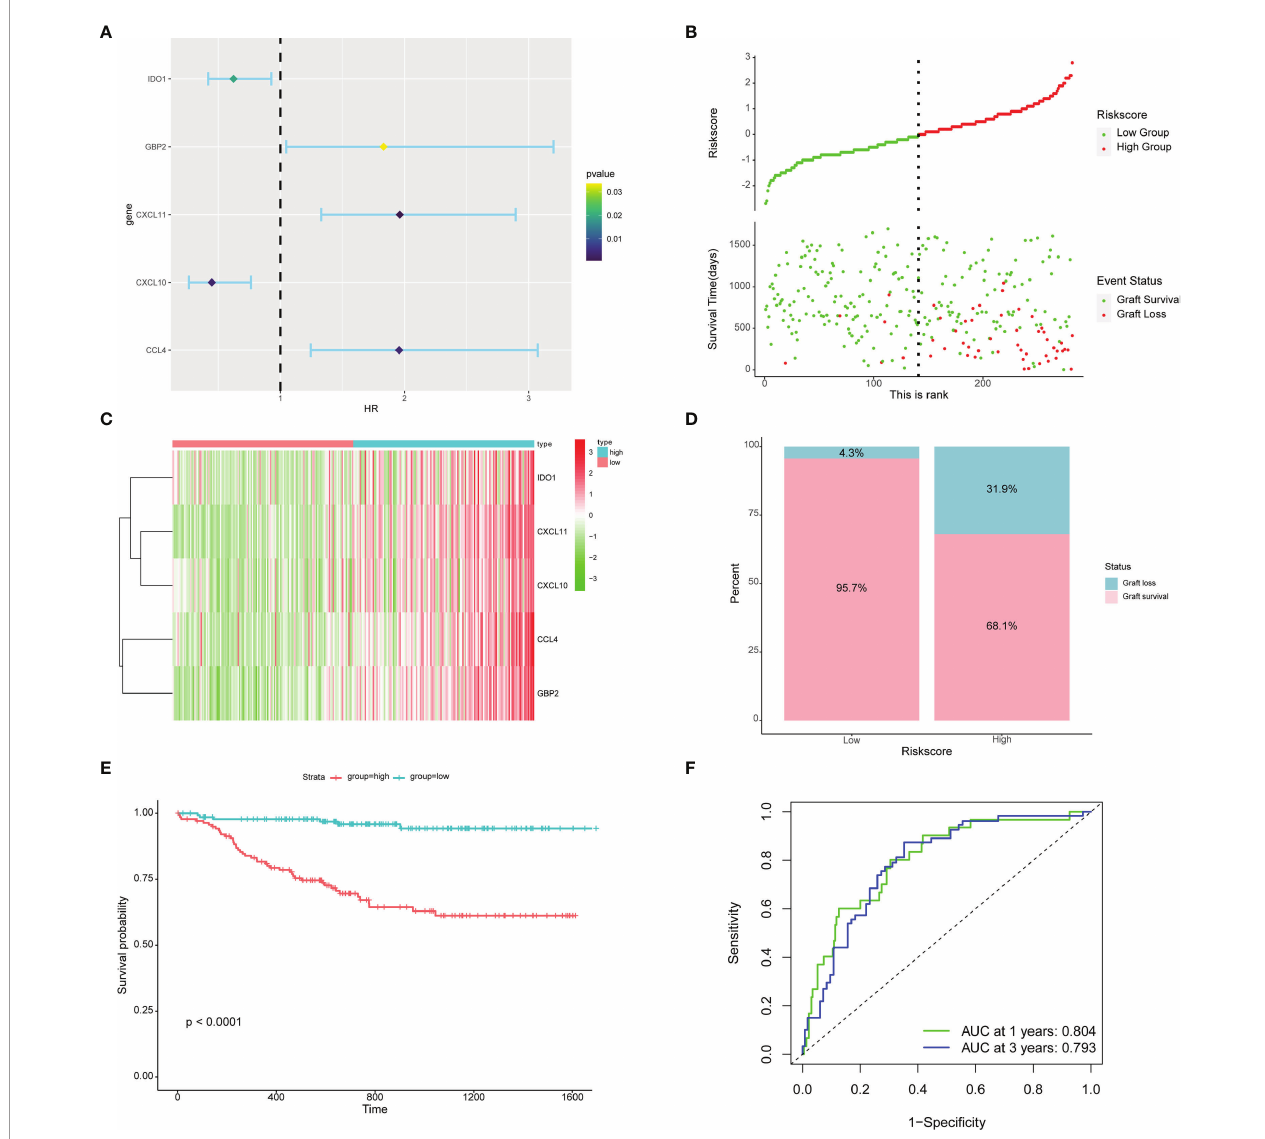
FIGURE 7 | Prognostic risk model building and evaluation. (A) Forest plot of fi ve genes related to graft loss analyzed by multivariate Cox regression. (B) RiskScore and graft survival time distributions of the low-risk and high-risk groups. (C) The heat map of fi ve prognostic-related genes. (D) The proportion of recipients strati fi ed by risk groups. (E) Survival analysis of recipients in different risk groups. (F) The AUC of the